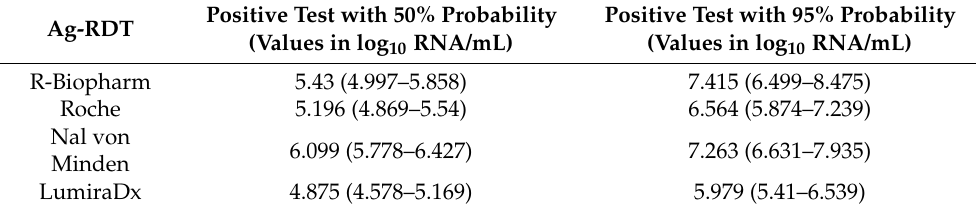
Positive Test with 50% Probability Ag-RDT (Values in log 10 RNA/mL)